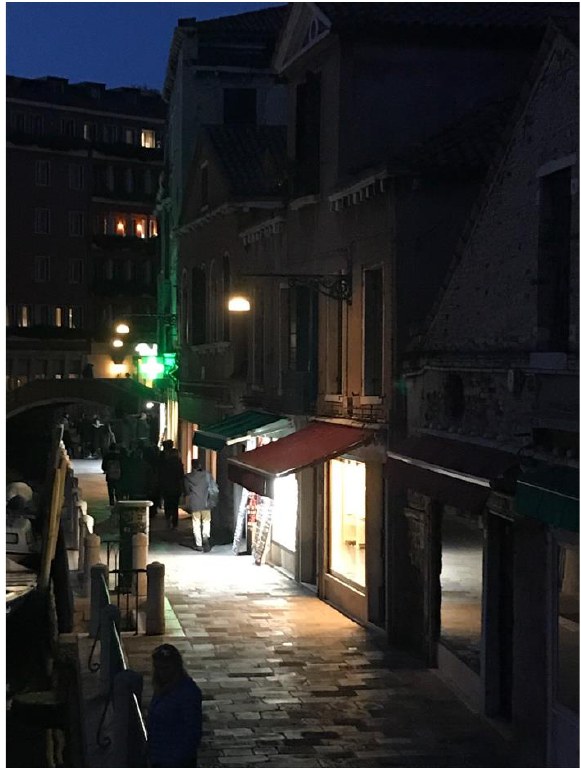
Figure 4. Shop in Santa Croce sestiere with very intense lighting compared to the context (D. Perissinotto, 2019).